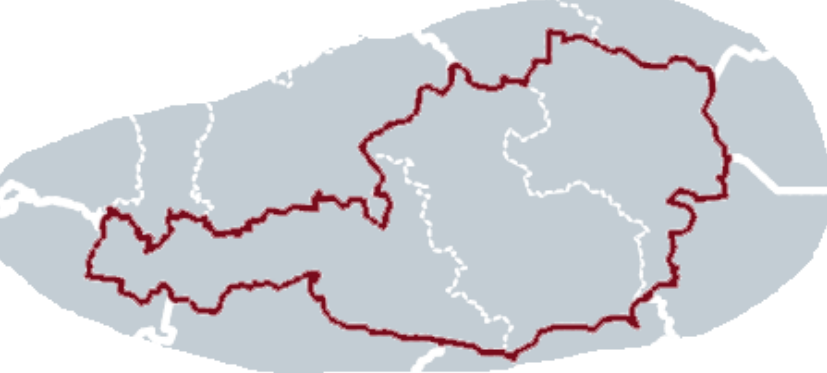
Figure 1. Split of APG control area (Austria, red) into three technical zones. The zones roughly correspond to (1) Vienna, Lower Austria and Burgenland (Zone East); (2) Upper Austria and Styria (Zone Mid); (3) Salzburg, Carynthia, Tyrol and Voral- berg (Zone West). This subdivision was introduced in the ENTSOE Ten Year Network Development Plan 2018 methodology [4]. It is not proposed to split the Austrian bidding zone into smaller bidding zones. This division is meant purely to facilitate the alloca- tion of call probabilities that—given the specificity of redispatch—depend on the unit’s location in the grid. In Austria, the bulk of wind and solar generation is located in Zone East, whereas Zone West contains most hydro and pump storage plants. Gas-fired power plants are spread across the country, with a focus on Zone East and Zone Mid. (See also https://globalenergymonitor.org/, accessed on 25 July 2022) In addition, Austria is an electricity transit country, which means that a lot of congestion is caused by the transit flows from the neighboring countries (please note that the Austrian TSO, for security reasons, does not publish the exact location of internal congestion). Each small technical zone is considered a copperplate. The call probabilities are varying on an hourly basis but not in between days. Ergo, no congestion forecasts are conducted for the simulation. However, a simulation of redispatch on a nodal basis is carried out, which considers cross-border activations, generation and consumption data. The call probabilities for the different re- gions are dependent on the geographical location of the congestions, direction (upward or downward), the frequency per year of a called product (within one time slot per day) and the volumes, as an outcome of the nodal